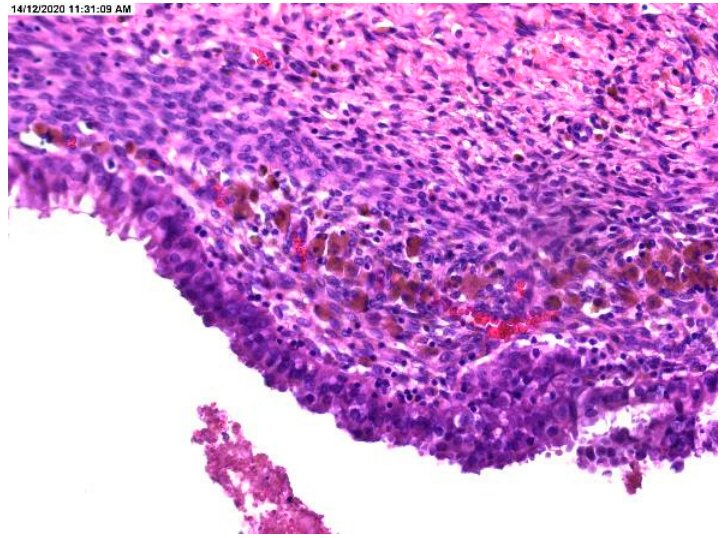
Figure 2. Cellular crowding in the lining of endometriotic cyst and markedly pigmented hemosiderin-laden macrophages.